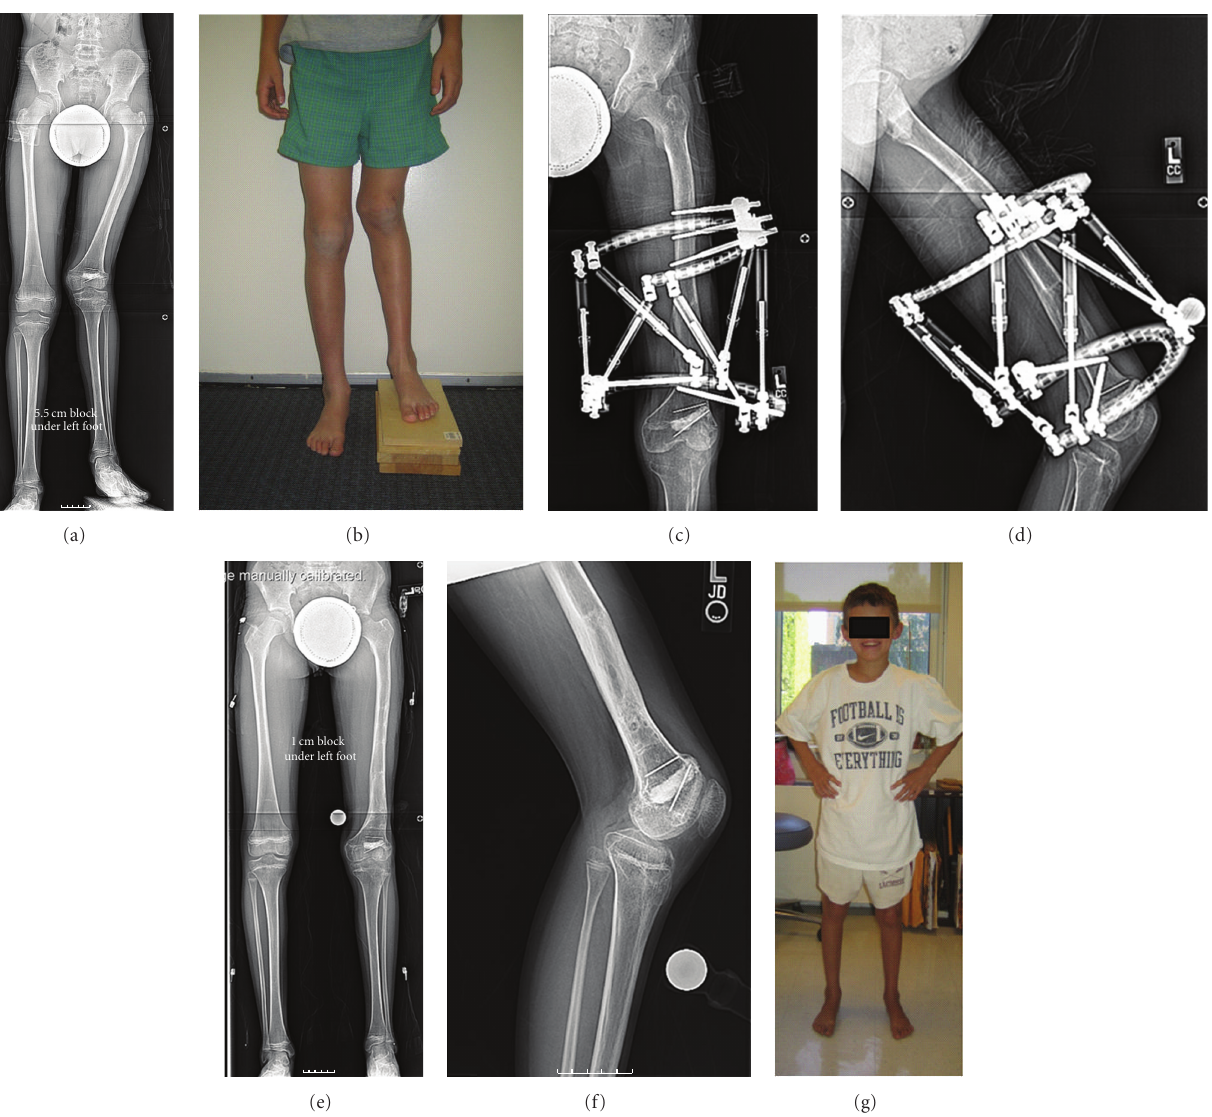
Figure 1: 10-year-old boy with left femur growth arrest resulting from a fracture. Prior unsuccessful attempt at bar resection was made. (a, b) Preoperative bipedal radiograph and front view showing valgus deformity and LLD of 6cm. (c, d) AP and lateral radiographs at end of distraction. An 8 cm lengthening was done with a Taylor spatial frame (Smith and Nephew, Inc., Memphis, TN). Over-lengthening was done in anticipation of additional discrepancy. (e, f, g) Follow-up 6 months after frame removal. while 2 patients underwent bilateral deformity